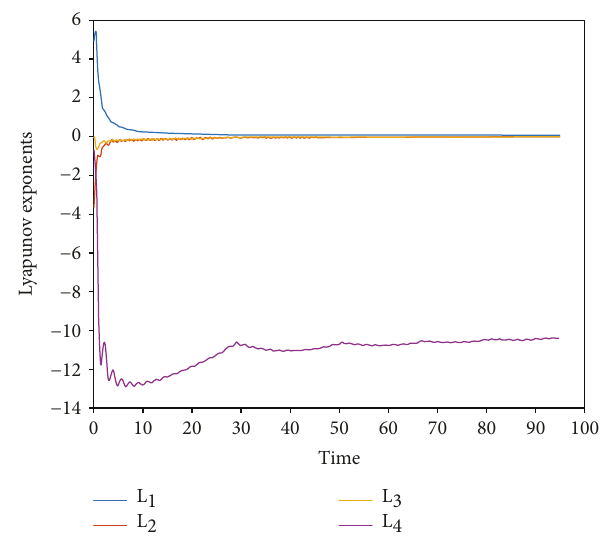
Figure 5: The Lyapunov exponent spectrum.